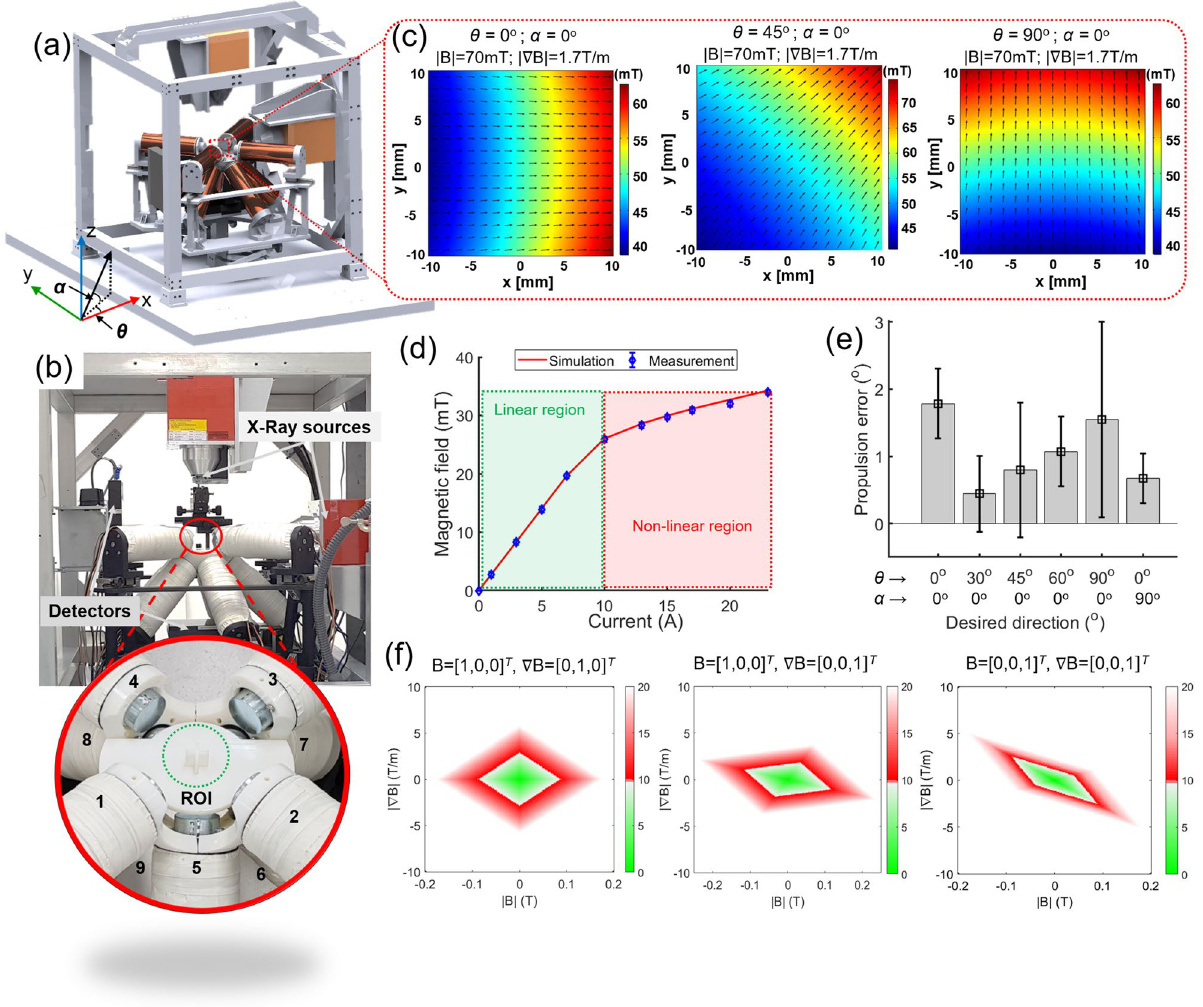
Figure 3. Design and implementation of EMA system. ( a ) Design of enhanced EMA system integrated with biplane X-ray system. θ and α are the alignment angle of the object’s desired orientation projected onto the X axis and XY plane, respectively. ( b ) Digital photograph of EMA system used in this work for investigating nanorobot motion. ( c ) COMSOL simulation results of magnetic field map generated by EnEMA system with magnetic and gradient fields of 70 mT and 1.7 T/m at orientations of θ = 0°, 45°, 90° and α = 0°, respectively. ( d ) Measured and simulated B–I curves of electromagnetic coil showing linearity of generated field with respect to applied current; green area represents linear region in which generated field is highly linear with respect to applied current; red area indicates non-linear region due to core saturation. ( e ) Propulsion test of system using 300 µm cylindrical magnet at 5 mT and 0.1 T/m. ( f ) Achievable magnetic and gradient fields in workspace at three orientations: θ B = 0°, α B = 0°, θ F = 90°, α F = 0°; θ B = 0°, α B = 0°, θ F = 0°, α F = 90°; θ B = 0°, α B = 90°, θ F = 0°, α F = 90°. In which θ B and θ F are the magnetic field and magnetic force angle along with the θ direction, respectively, and α B and α F are the magnetic field and magnetic force angle along with the α direction,